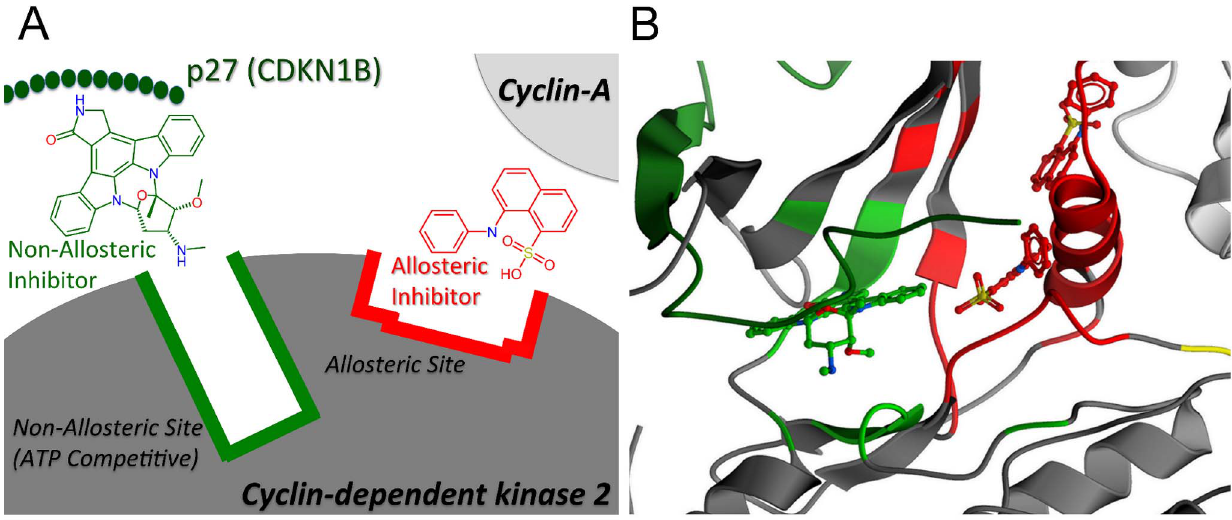
Figure 1. The concept of multiple binding sites on a single protein visualized schematically (A) and in protein data bank structure 1JSU (B). The ATP binding site was shown in green on cyclin dependent kinase 2 (CDK2) (grey), commonly referred to as the orthosteric binding site. One allosteric binding site (type V inhibitors) was shown in red, closely located to the orthosteric binding site. Also shown was a non-allosteric inhibitor (green, projected from PDB 1HCK) and an allosteric inhibitor (red, projected from PDB 3PY1). Finally cyclin-A was visualized pairing (light grey) with CDK2 and the natural inhibitor CDKN1B (dark green) to show the potential of allosteric inhibitors to disrupt the CDK2- cyclin-A protein- protein